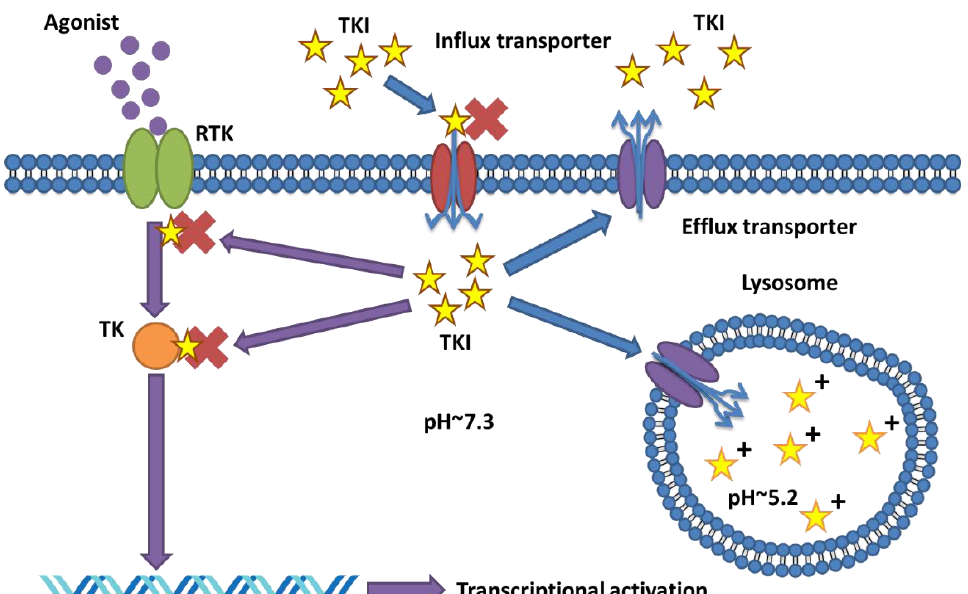
Figure 1. General overview of the mechanism of action and resistance for TKIs (Tyrosine kinase inhibitors). Receptor tyrosine kinases (labelled RTK) activate tyrosine kinases (labelled TK) downstream leading to transcriptional activation. Most cases of resistance involve punt mutations in the drug target (represented by the ×). Alternatively, TKI can be sequestered in the lysosome and protonated (indicated by the +) or removed from the cell through efflux transporters.